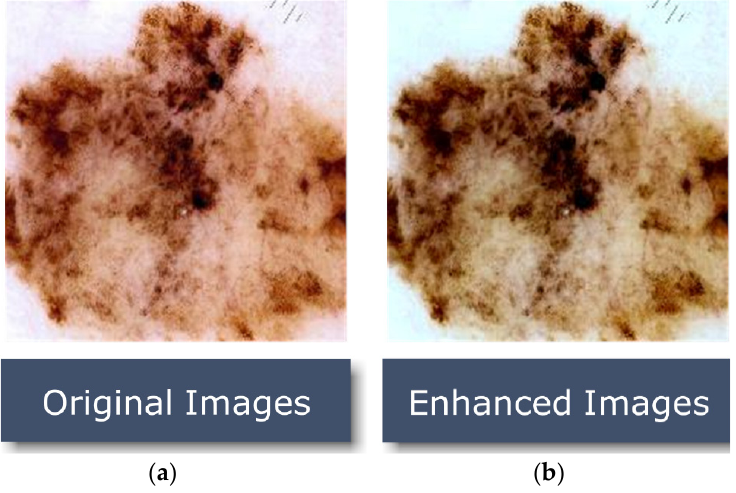
Figure 4. Proposed image-enhancement algorithm results; ( a ) image in its raw form; ( b ) an enhanced version of that image.